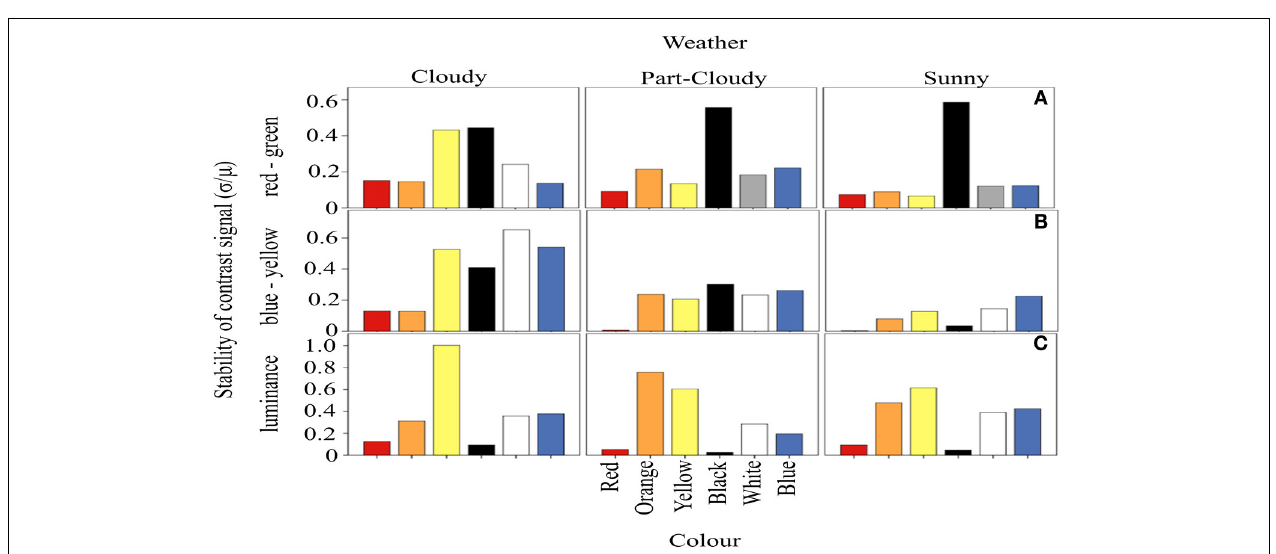
Despite the variations, red remains as the most contrasting color (A,B) , and it is very stable in the BY opponent system (B) , contrary to our predictions. Achromatic signals (black and white) (C) have great variation, indicating that these colors should not be considered a reliable warning signal.